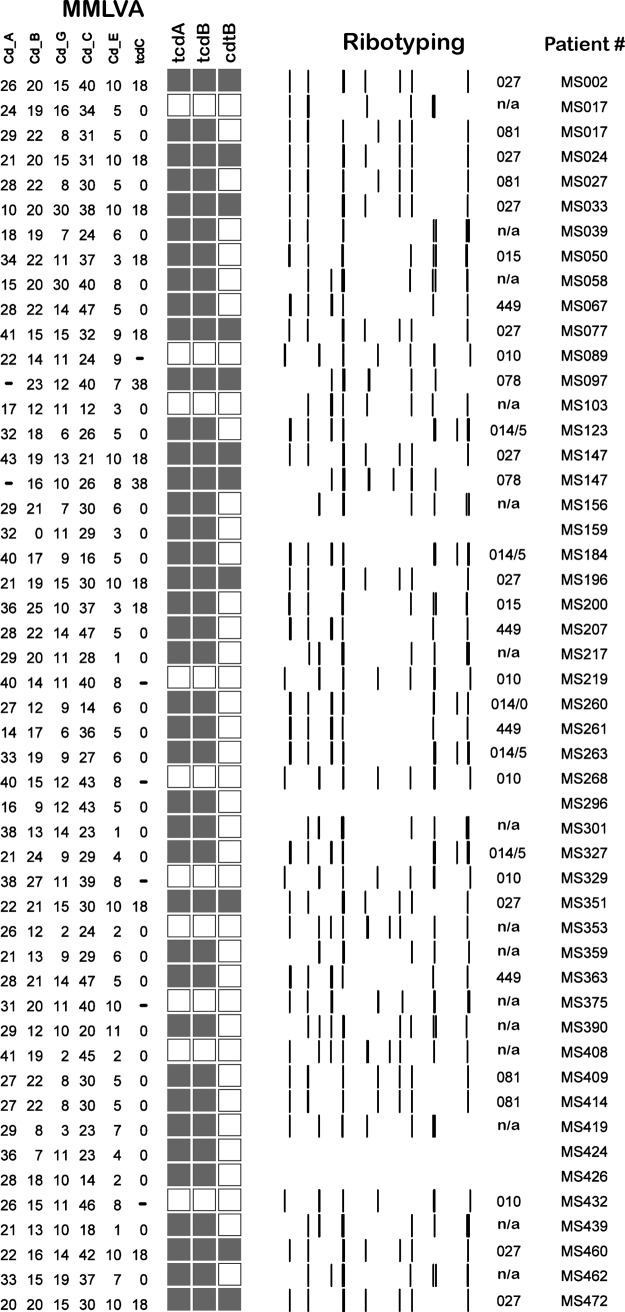
Ribotyping analysis in CD colonized individuals.Asymptomatic carriers were detected carrying several toxigenic (filled boxes) and non-toxigenic (unfilled boxes) ribotypes, including the hyper-virulent ribotype-027 (MS002, MS024, MS033, MS077, MS196, MS351, MS460, and MS472). In some cases an individual was asymptomatically colonized with multiple toxigenic ribotypes including ribotype-027 and ribotype-078 (MS147). Other toxigenic isolates were also prevalent in our patient population including ribotypes 014, 015, 078, 081, 449. Of note, one asymptomatic participant harbored both toxigenic and non-toxigenic CD isolates together (MS017). TcdA–toxin gene A, TcdB–toxin gene B, CdtB–binary toxin gene.